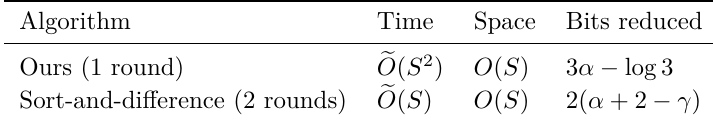
Table 2: Complexities and the number of reduced bits Algorithm